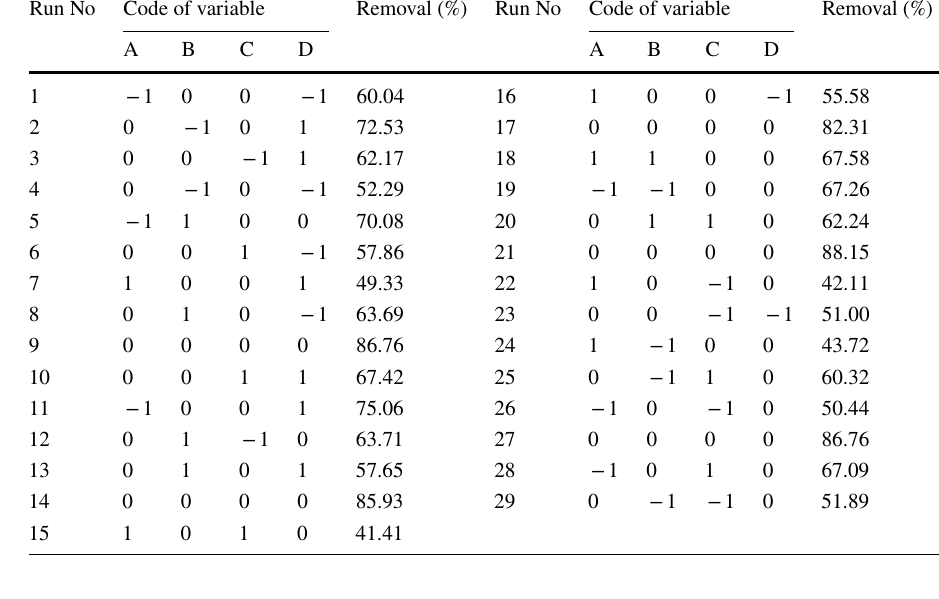
Run No Code of variable